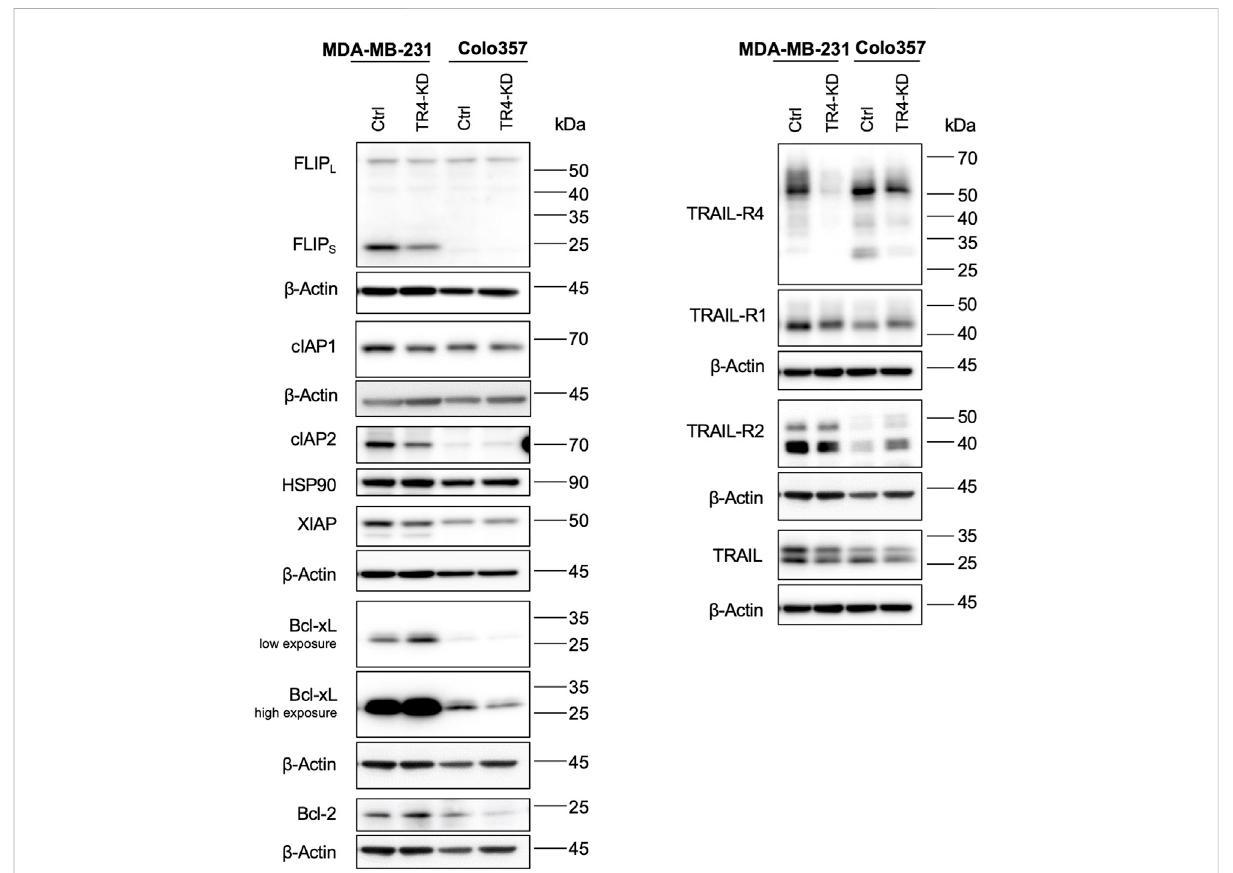
FIGURE 7 Impact of TRAIL-R4 on the expression levels of anti-apoptotic proteins, TRAIL-Rs and TRAIL in MDA-MB-231 and Colo357 cells. MDA-MB- 231 and Colo357 control (Ctrl) and TRAIL-R4-knockdown (TR4-KD) cells were seeded at 3.3 × 10 5 /well (Colo357) and 3 × 10 5 /well (MDA-MB-231) in 6-well format and 24 h later whole-cell lysates were prepared. Western blot analysis of anti-apoptotic proteins FLIPL/S, cIAP1, cIAP2, XIAP, Bcl-xL, Bcl-2 and TRAIL receptors (TRAIL-R4, -R1, -R2) and TRAIL were performed. Detection of β -Actin served as a loading control. Shown are representative pictures from one related experiment out of three biological